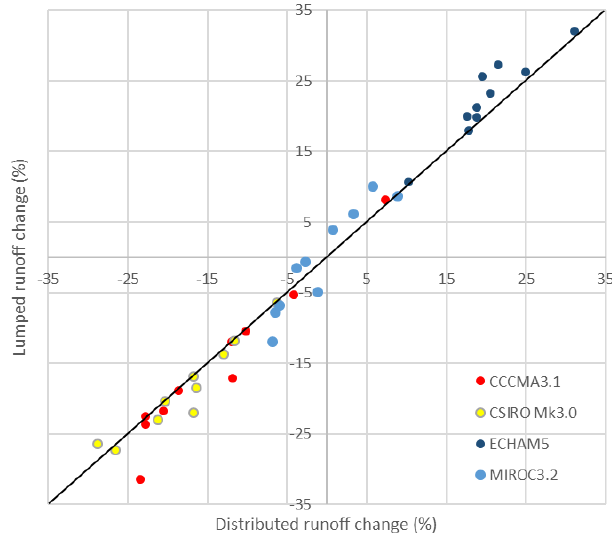
Figure 8. Distributed versus lumped change (future period relative to current period) in mean annual runoff